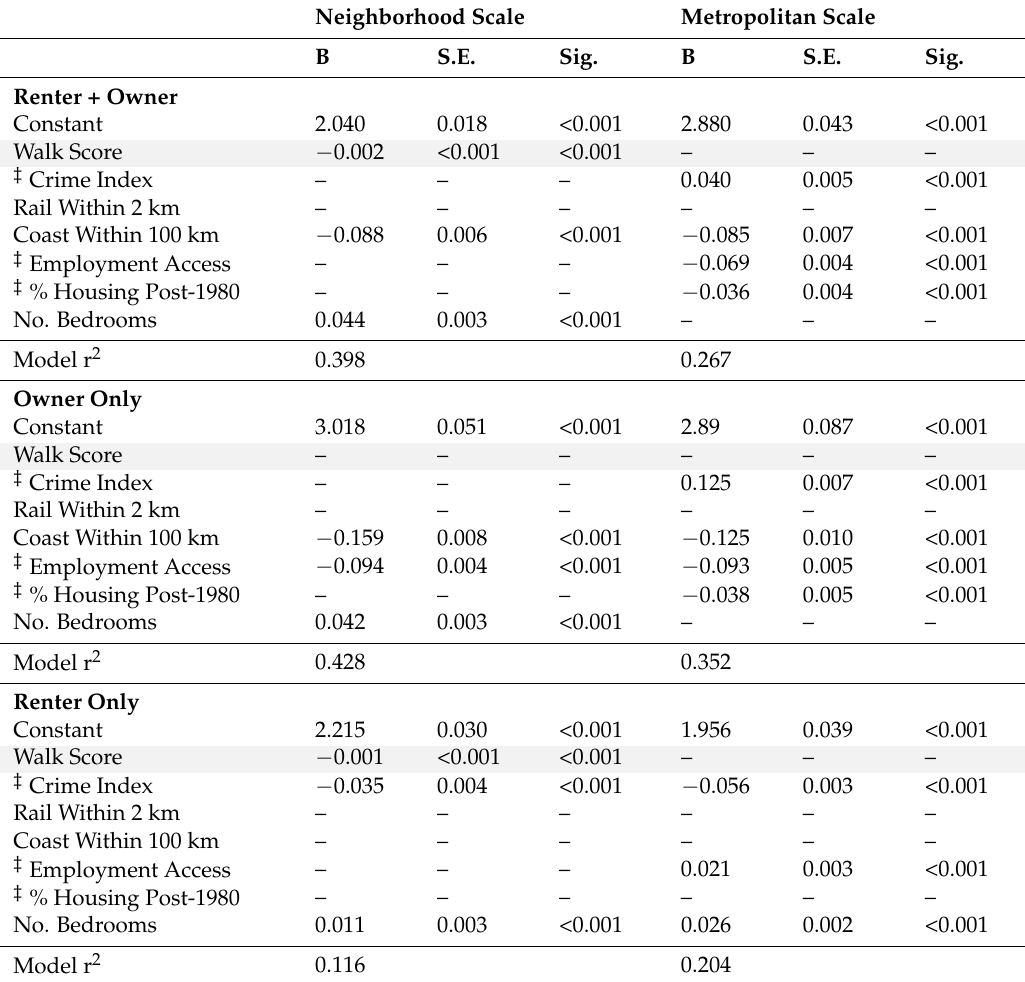
Table 1. Results of the OLS regression analysis (stepwise procedure) of randomly selected census tracts (N = 2300) within U.S. urbanized areas, with the log (10) of the combined renter and owner (CHAI), owner only (HAI), and renter only (RAI) housing affordability indices as the dependent